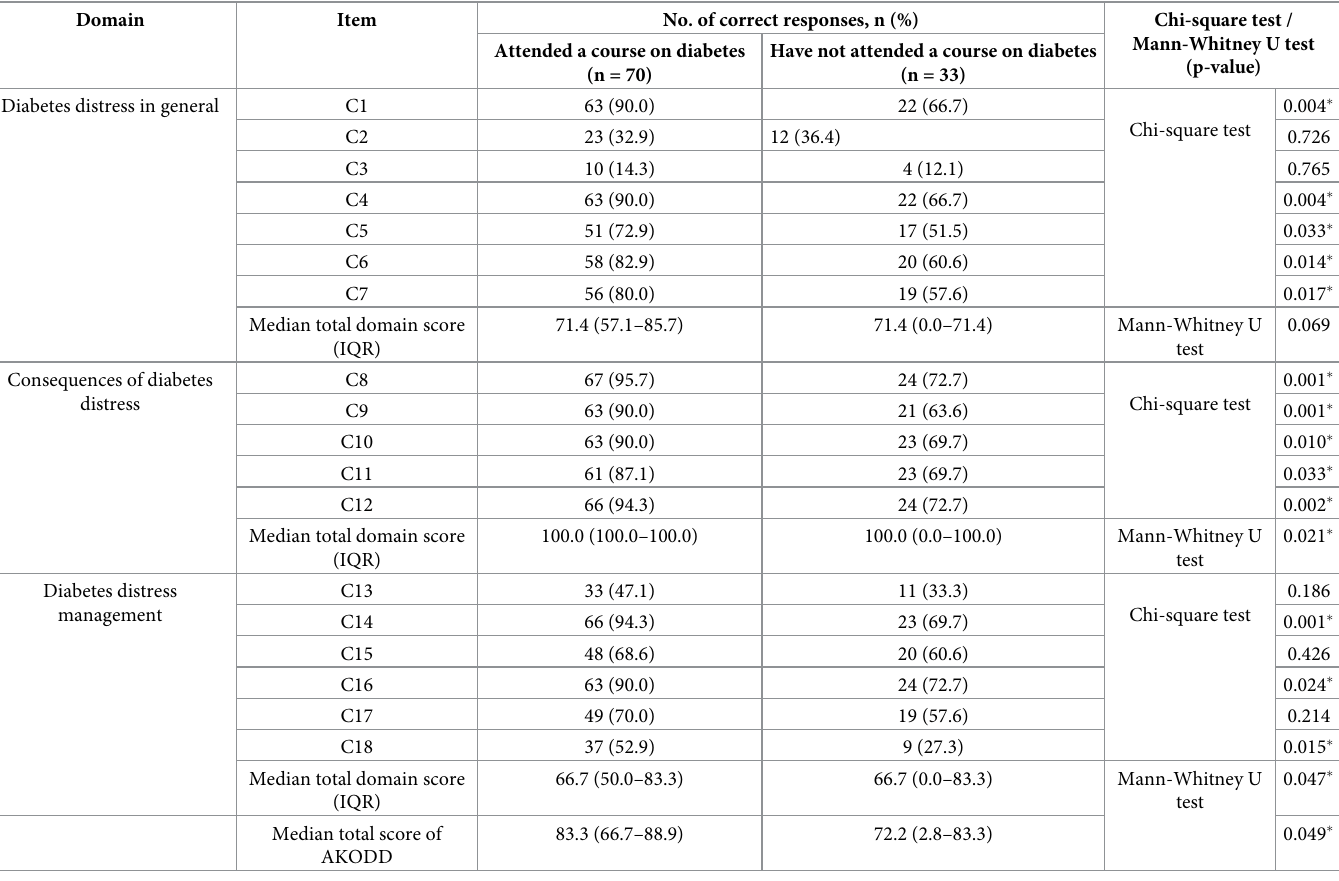
Table 3. The discriminative validity of the awareness and knowledge of diabetes distress (AKODD) questionnaire.